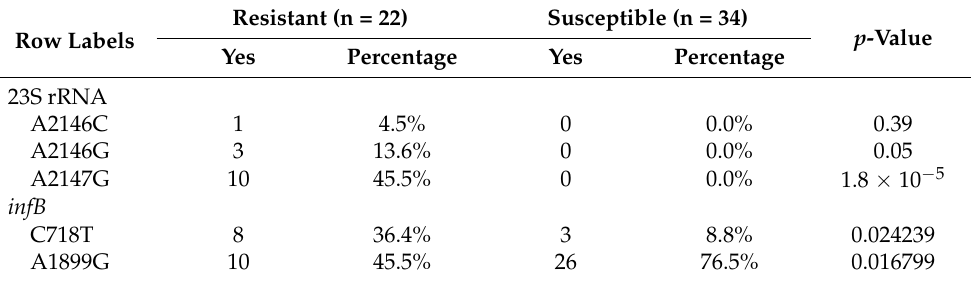
Table 4. The point mutation occurred in the clarithromycin resistance.